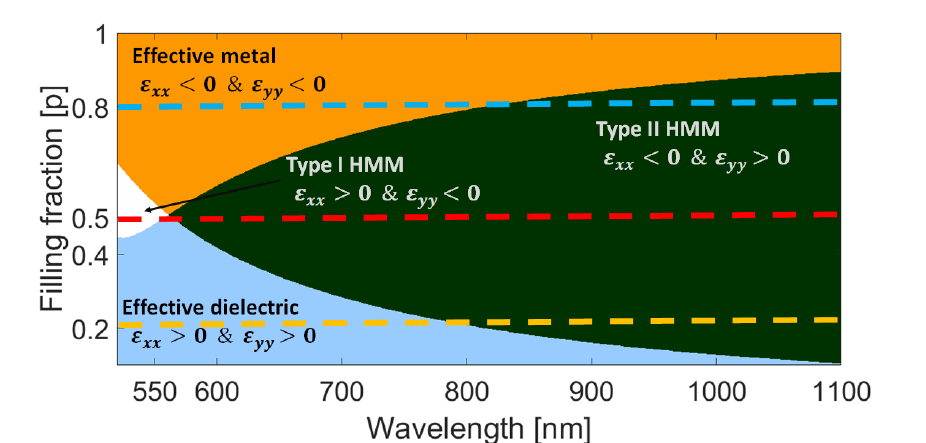
Figure 3. Phase diagram of the metamaterial composed by layers of Au/TiO 2 as a function of the filling fraction and wavelength. The first region in blue (lower left corner) corresponds to an effective dielectric behavior when (cid:101) xx > 0 and (cid:101) yy > 0. The second region in orange (upper left corner) corresponds to an effective metal when (cid:101) xx < 0 and (cid:101) yy < 0. The third region in white corresponds to a Type I HMM for which (cid:101) xx > 0 and (cid:101) yy < 0 and the fourth region in green corresponds to a Type II HMM for which (cid:101) xx < 0 and (cid:101) yy > 0. Dotted lines point out the behavior of the multilayerd system for p = 0.2 (yellow) , p = 0.5 (red) and p = 0.8